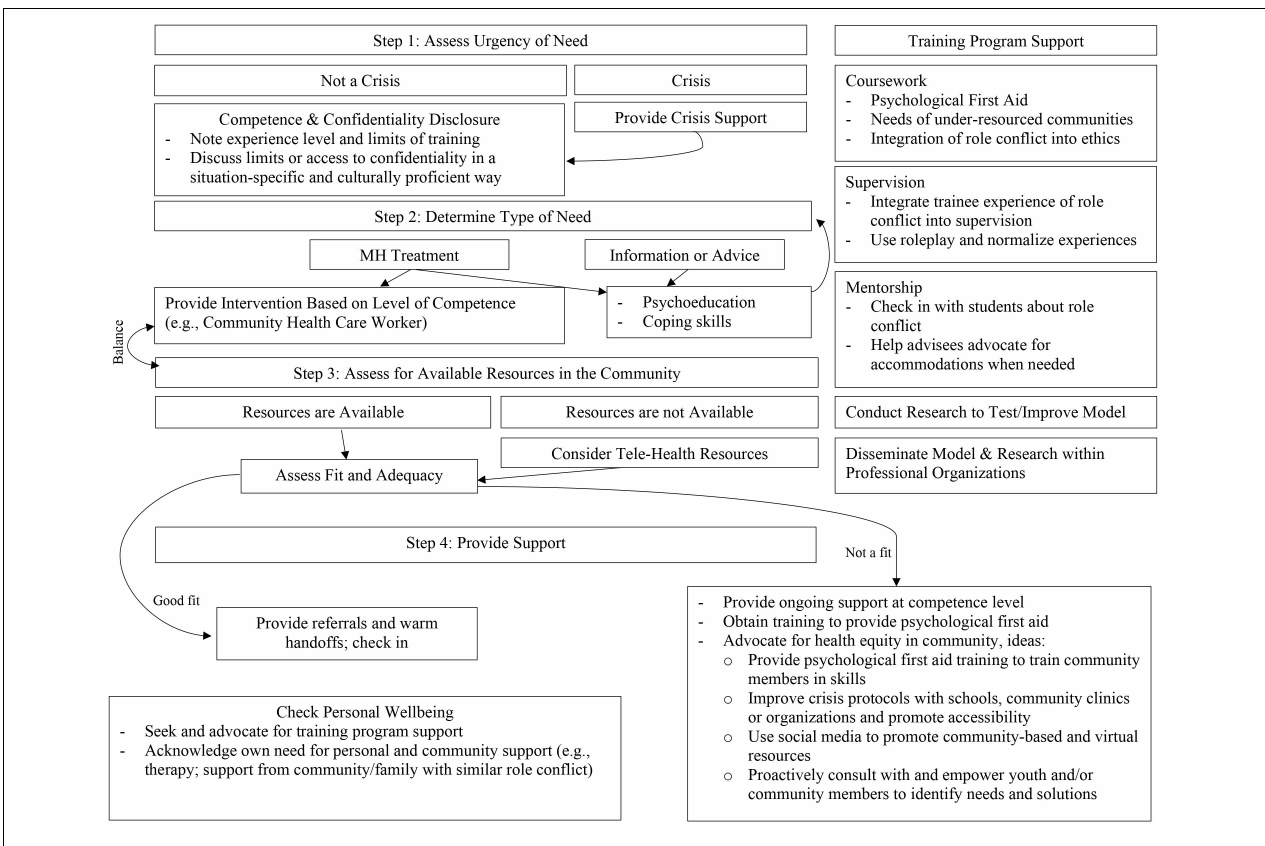
FIGURE 2 | Associated flowchart for the proposed Decision-Making model for addressing role conflict for psychology